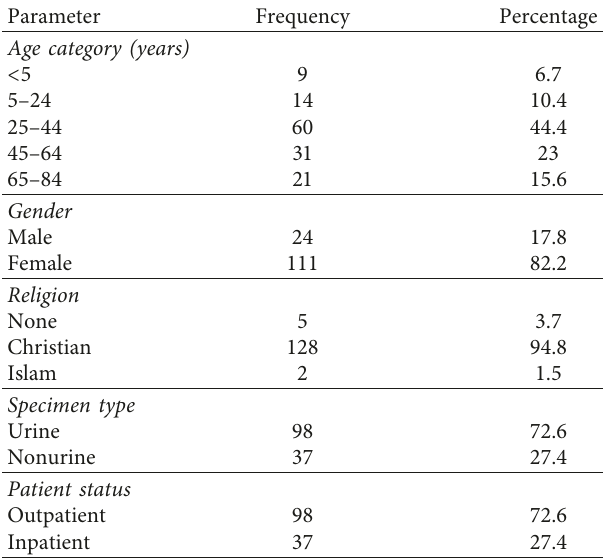
Table 3: Sociodemographic characteristics of study